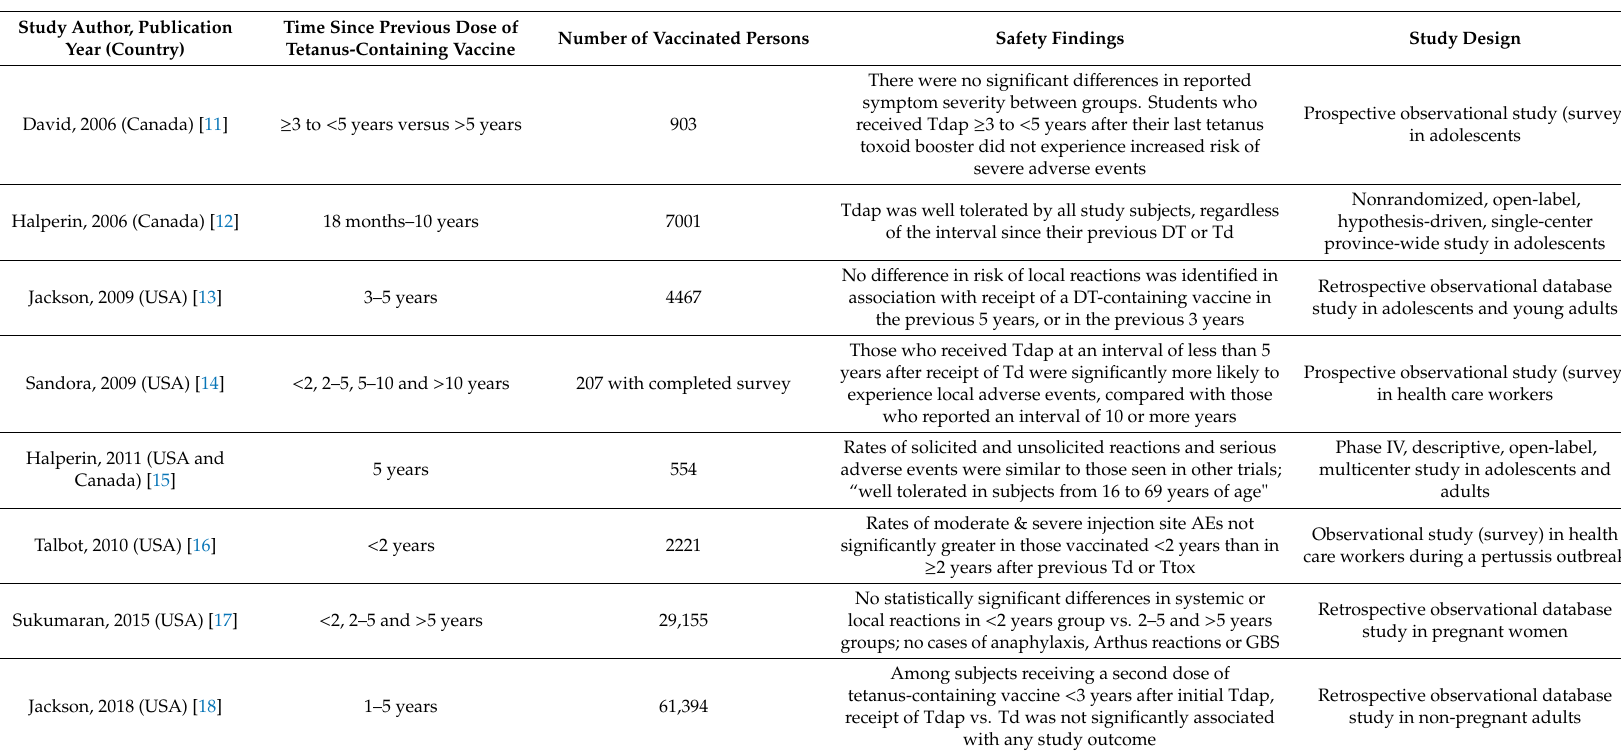
Table 1. Studies in PubMed on the safety of Tdap vaccination in persons who received a tetanus toxoid-containing vaccine ≤ 5 years previously, published